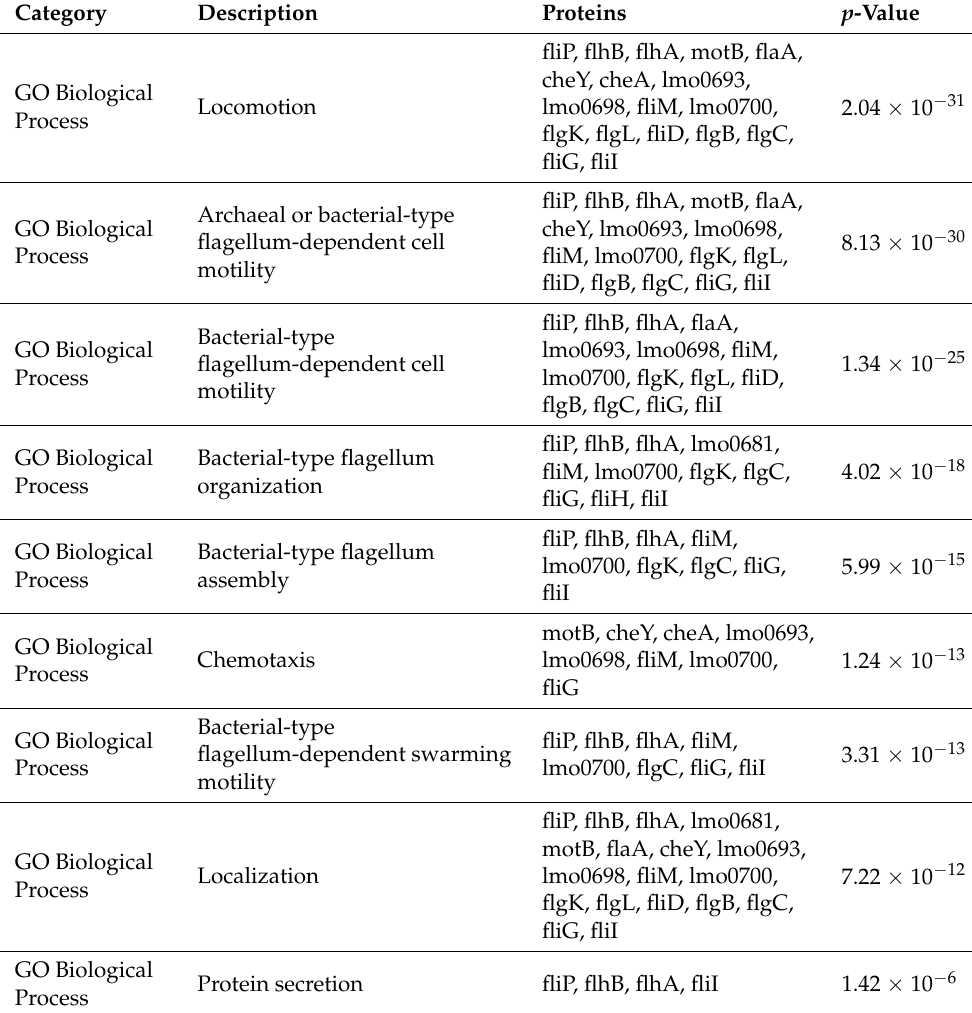
FliP, with proteins FliQ and FliR, forms the core of the central channel in the flagella export apparatus. Lmo0681 protein; positive regulator of class III flagellar genes. One of three proteins involved in switching the direction of the flagellar rotation. RNA polymerase sigma factor; sigma factors are initiation factors that promote the attachment of RNA polymerase to specific initiation sites and are then released. Lmo0715; binds to and inhibits the function of flagella specific ATPase FliI.